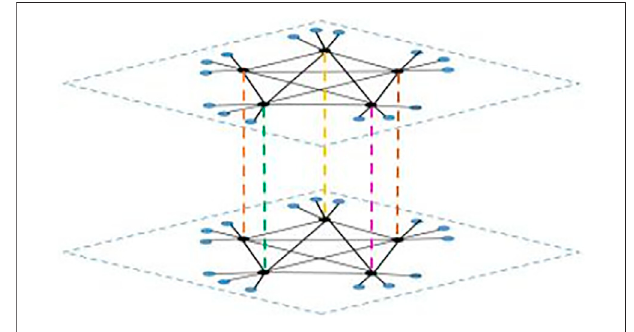
FIGURE 1 | An example of A , n (cid:1) 5, p (cid:1)